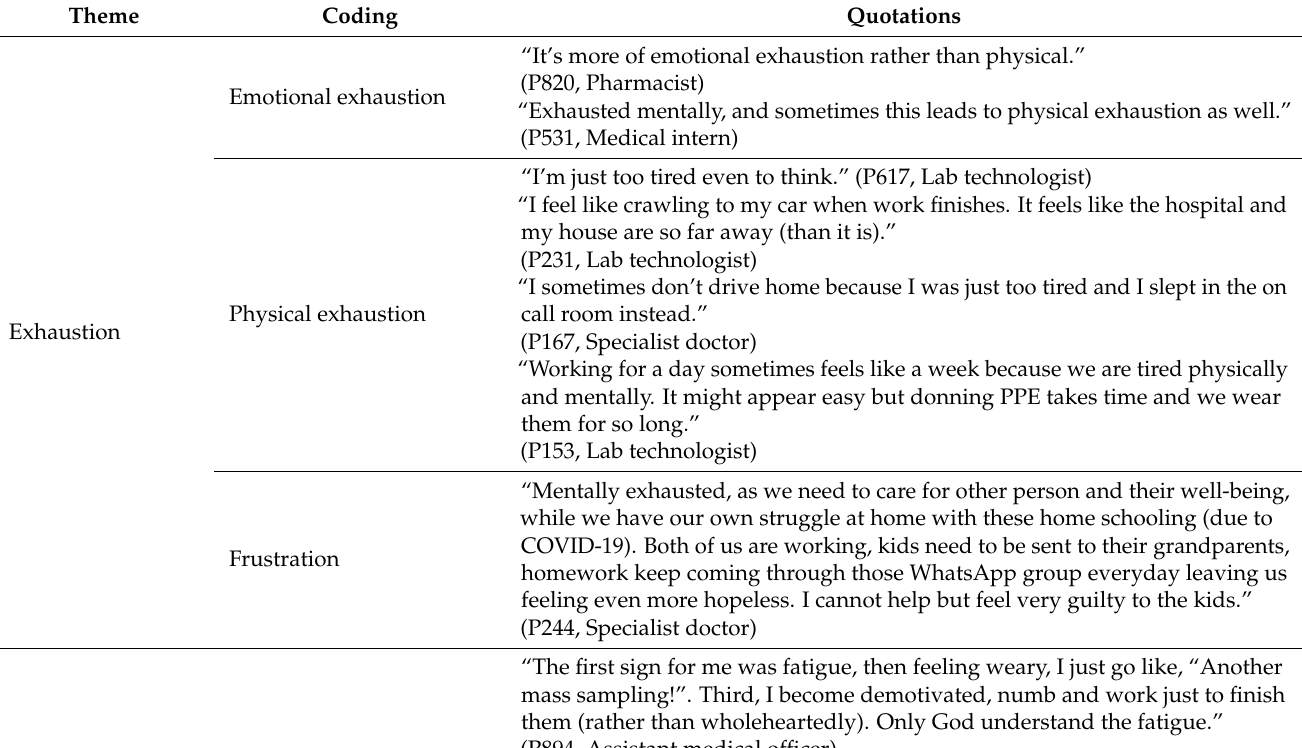
Table 6. Common self-reported symptoms of burnout in